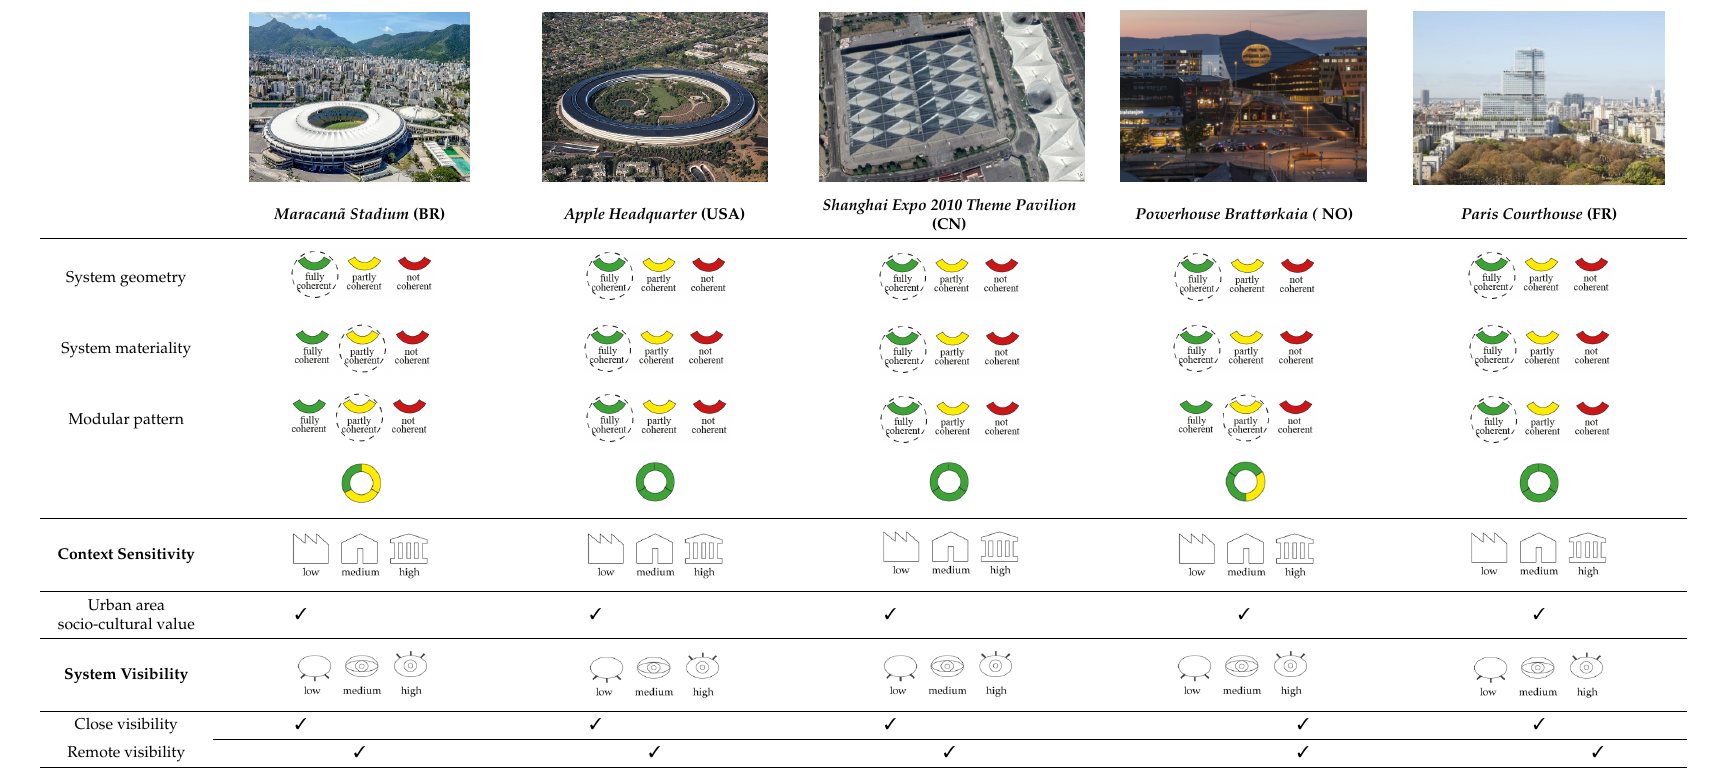
Table 4. Architectural integration quality, context sensitivity and system visibility of the landmark buildings (first part).